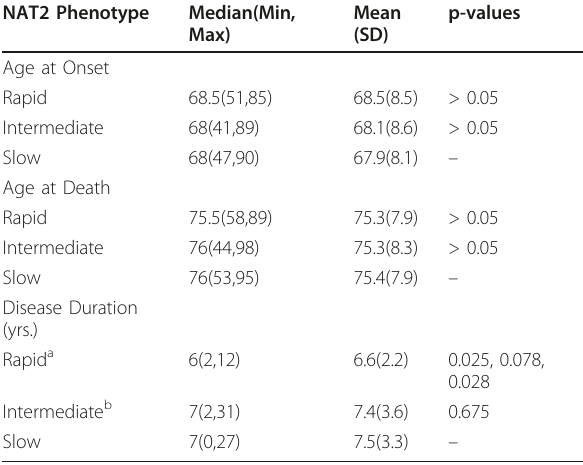
Pairwise comparisons of age at onset, age at death, and disease duration by NAT2 phenotype ( t -test with unequal variances). a p-values = rapid vs. slow, rapid vs. intermediate, rapid vs. slow + intermediate, respectively. b p-value = slow vs. intermediate. Overall p-values from Wilcoxon rank sum tests were all >